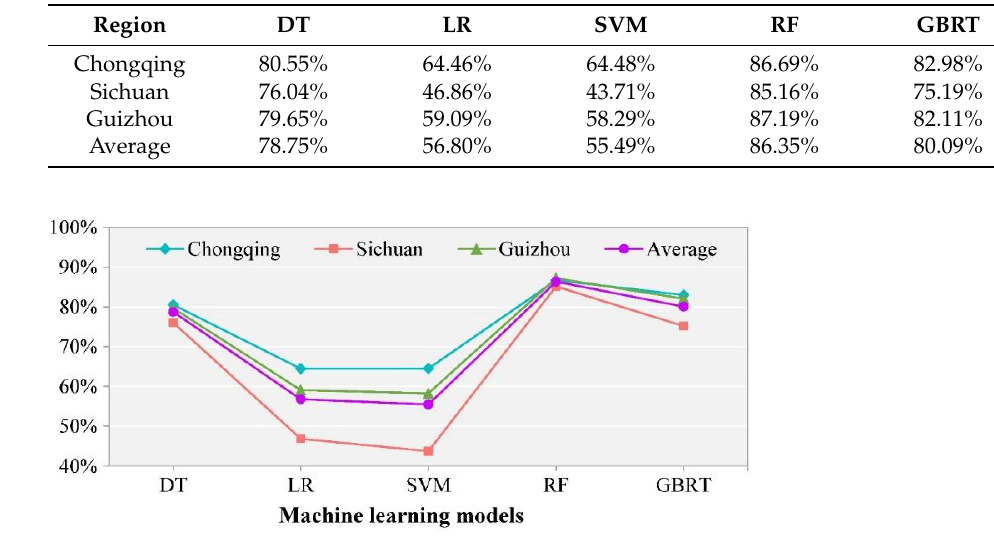
Figure 7. Accuracy evaluation of five machine learning models. DT, Decision Tree; LR, Logistics Regression; SVM, Support vector machine; RF, Random Forest; GBRT, Gradient Boosting Regression Tree.